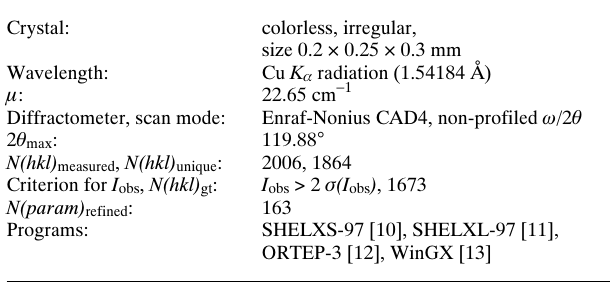
Table 1. Data collection and handling.